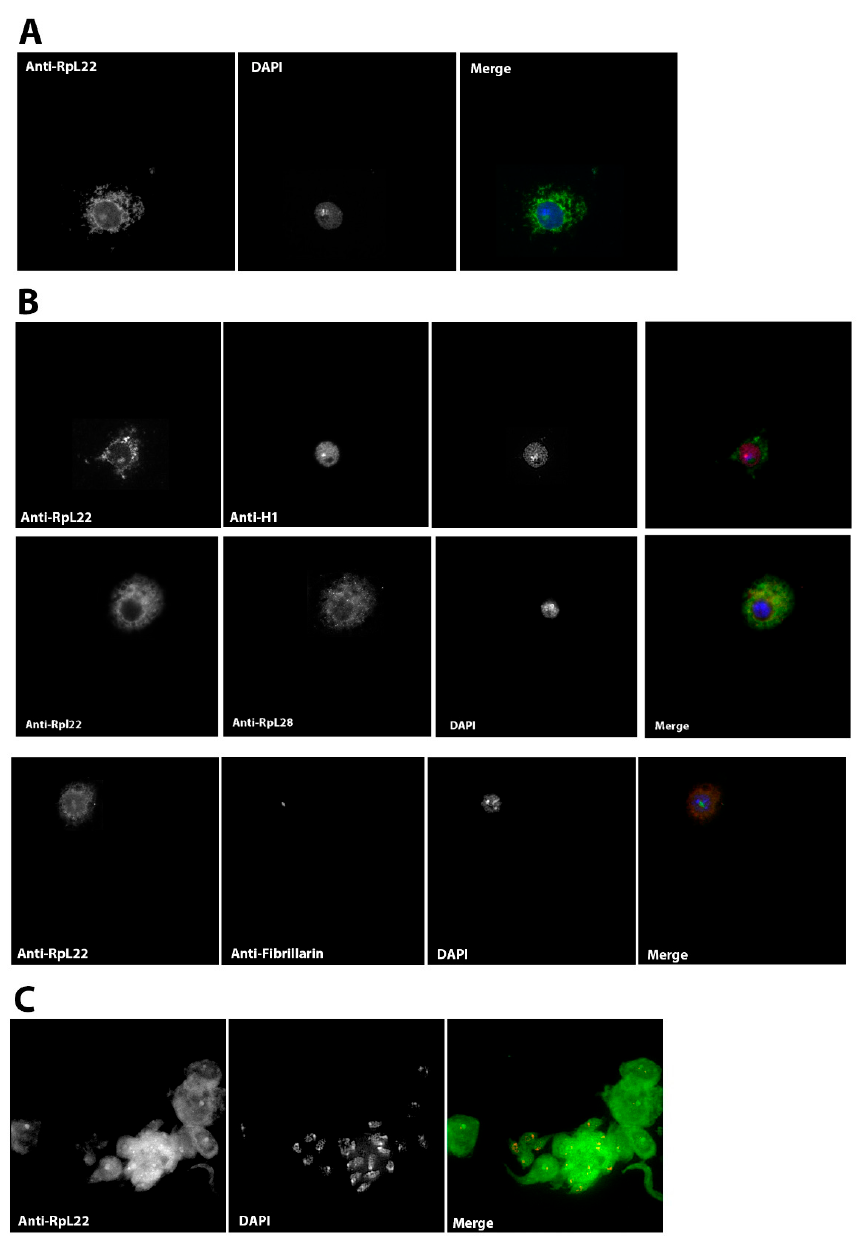
Figure 4. RpL22 localization in Drosophila cell line S2R + and in the brain cells. ( A ) Rpl22 localizes both in cytoplasm and nucleolus in S2R + cell. ( B ) To highlight the “ribosomal” behavior of RpL22, co-immunofluorescence experiments were performed both with the anti-H1 antibody and anti-RpL28 antibody, finally, as further confirmation of the nucleolar localization, RpL22 co-localizes with the nucleolar marker of fibrillarin. ( C ) The same localization pattern occurs (cytoplasm and nucleolus) also in neurons. To confirm the cellular and subcellular localization of RpL22 also in tissues other than cultured cells and germline tissues, we performed immunofluorescence experiments also